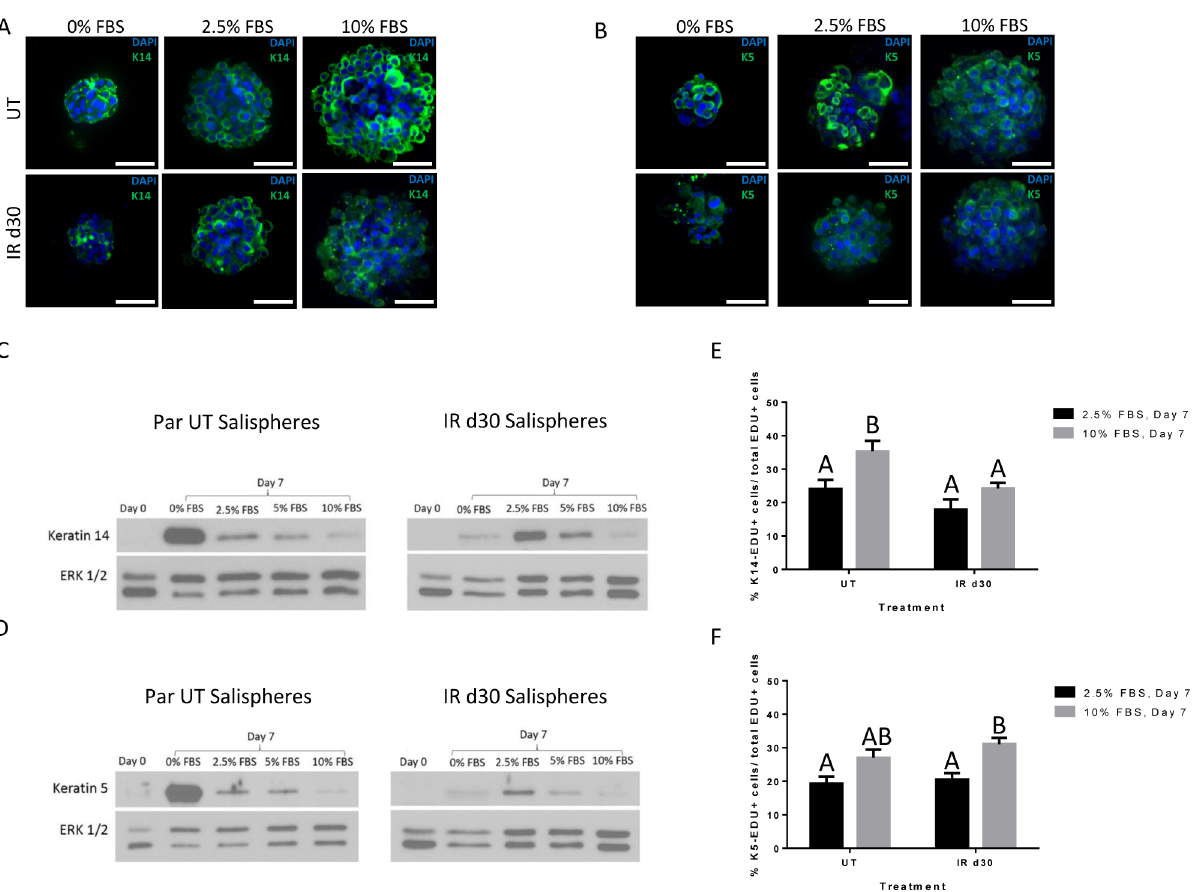
Fig 5. Expression of salivary stem/progenitor markers by salisphere cells. Untreated and irradiated parotid-derived salispheres, maintained under different FBS concentrations, were fixed after 7 days in culture and stained for Keratin 5 (K5) or Keratin 14 (K14) (green). Representative confocal immunofluorescence images are shown (A-B). Representative immunoblot of protein extracts from untreated and irradiated salispheres grown under different FBS concentration medium, collected at day 7 in culture, and probed for Keratin 5 and Keratin 14 (C-D). On day 7 of culture, salispheres were labelled with EdU for 1 hour in vitro , fixed, and dual stained for EdU and Keratin 5 or Keratin 14. Percentage of dual EdU-K14+ or Edu-K5+ cells was quantified from 20 salispheres, maintained under different FBS concentrations, for both treatment groups and expressed as mean percent of K14+ or K5+ proliferating cells ( ± SEM) within an individual salisphere. Significant differences (p < 0.05) were determined using a one-way ANOVA followed by post-hoc Tukey multiple-comparison tests. Groups with the same letter are not significant different from each other (E-F). Scale bar = 50 μ m.